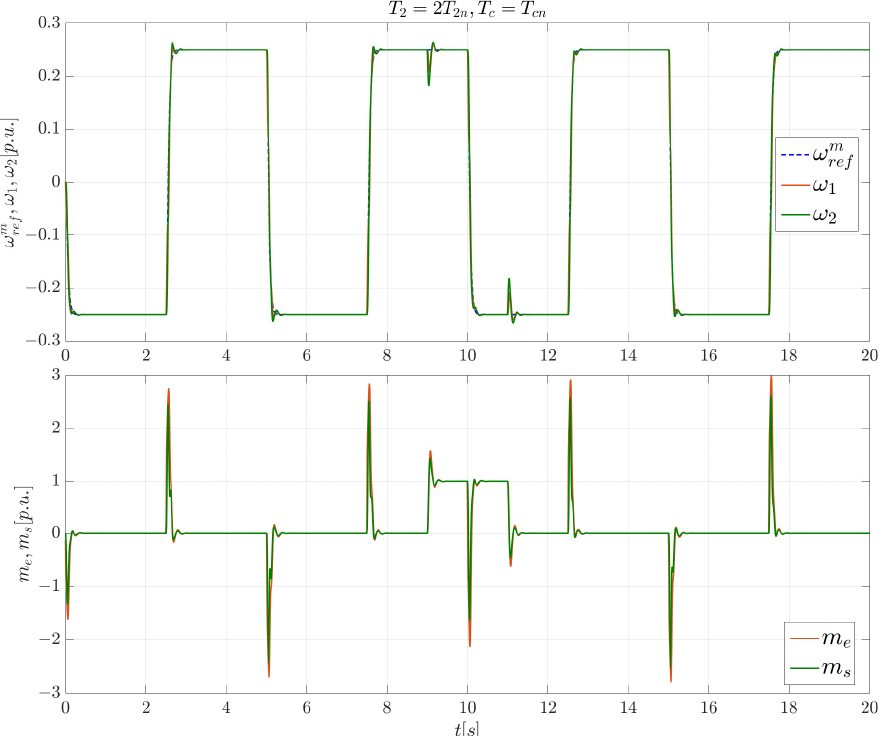
Figure 8. Speeds ( ω ref , ω 1 , and ω 2 ) and torques ( m e and m s )—transients for increased load time constant ( T 2 = 2 T 2 n ).